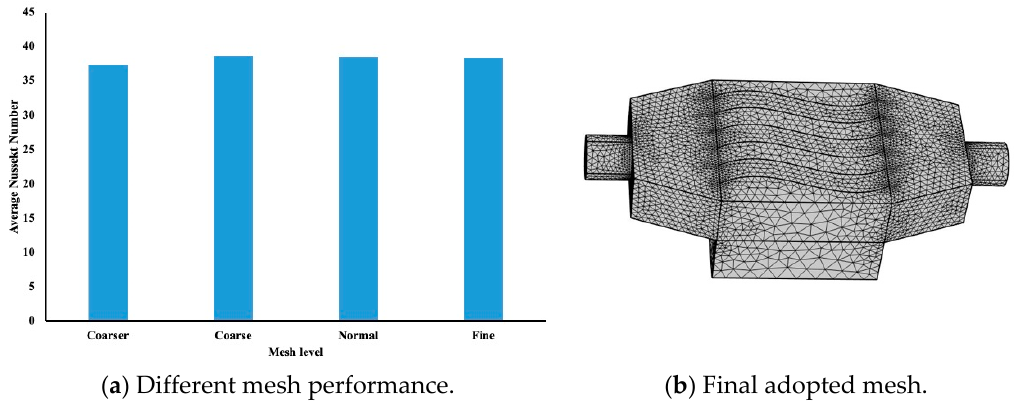
Figure 2. Mesh sensitivity analysis. ( a ) Different mesh performance. ( b ) Final adopted mesh.